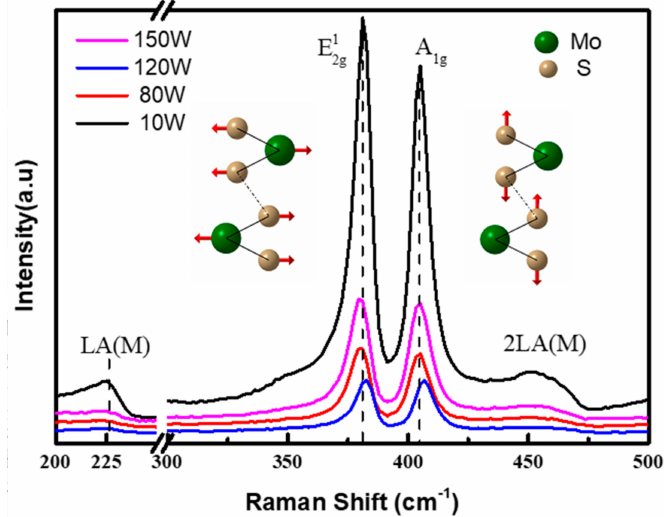
Figure 2. Raman spectra of the MoS 2 thin films deposited on SiO 2 /Si substrates under different radio frequency (RF) powers. The insets illustrate the oscillating mode of the E 1 2 g and A 1g